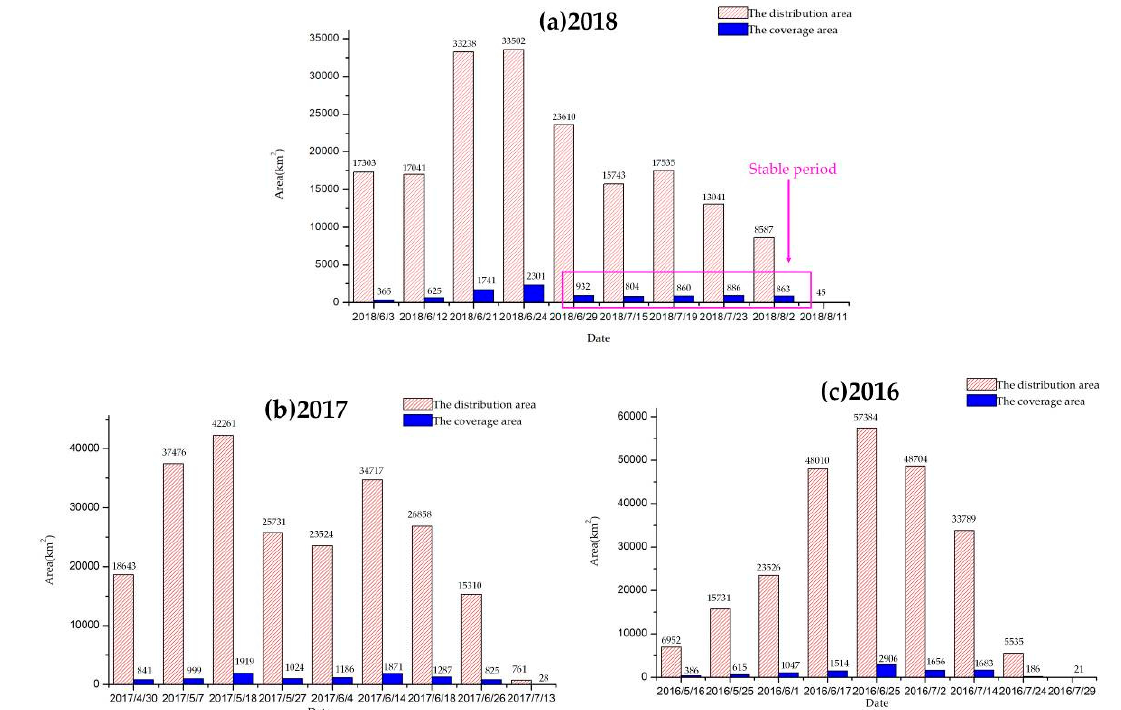
Figure 14. ( a ) Histogram of U. prolifera distribution and coverage area in 2018. The abscissa is the date, and the ordinate is the area in square kilometers. The stable period of the coverage area in 2018 is highlighted and marked by magenta boxes in the graph. ( b ) Histogram of U. prolifera distribution and coverage area in 2017. ( c ) Histogram of U. prolifera distribution and coverage area in 2016.